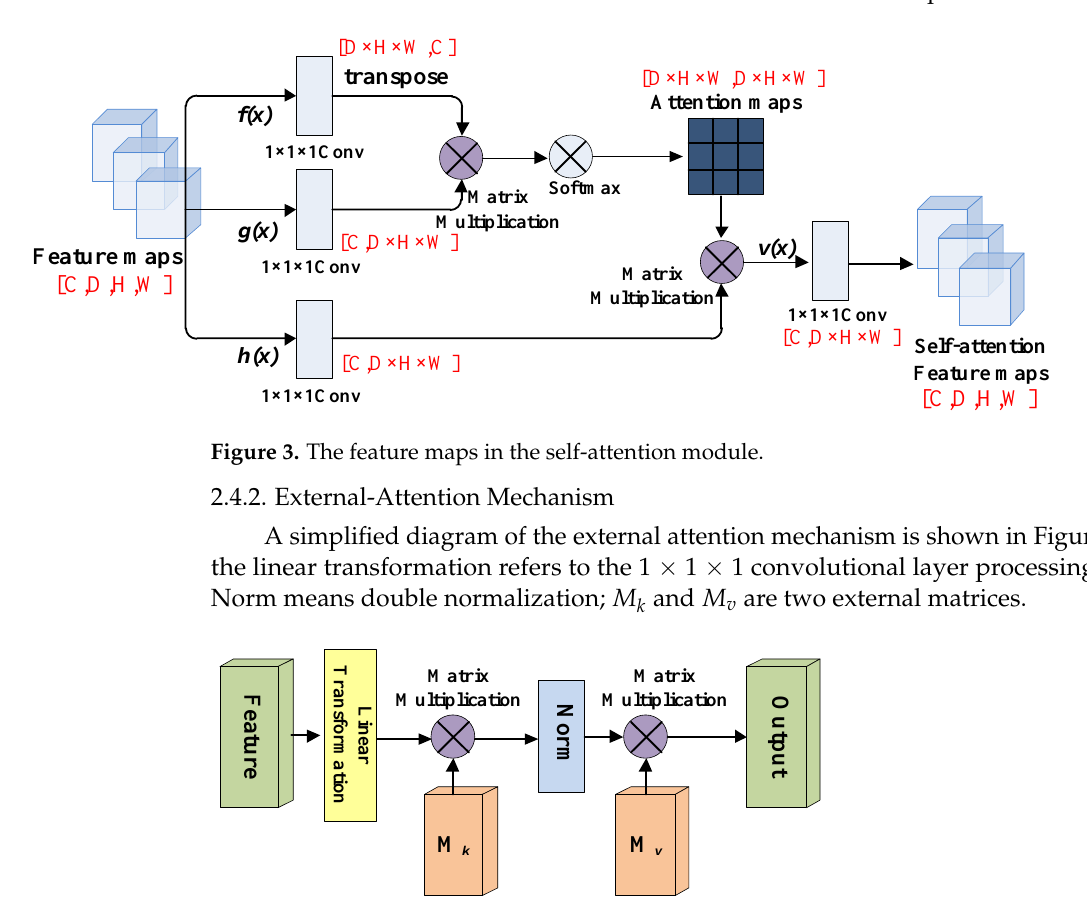
Figure 4. Diagram of the external-attention mechanism.